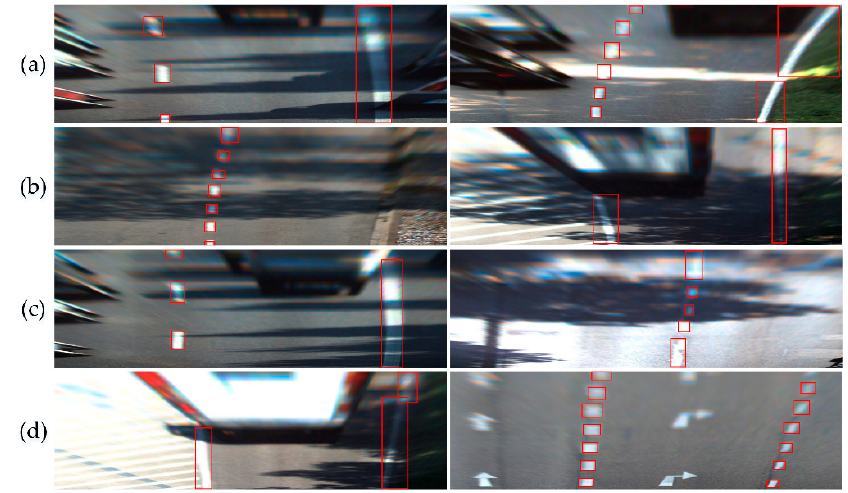
Figure 6. Detection results of the second-stage KITTI model on the KITTI dataset.